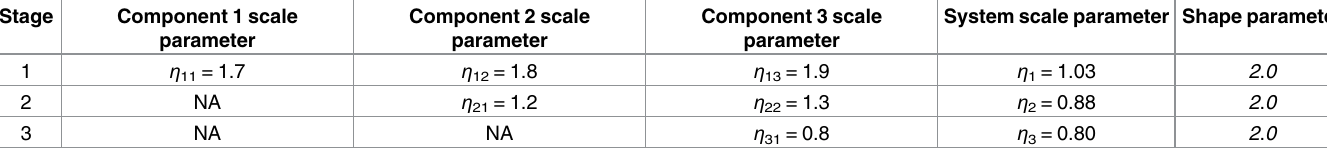
Table 3. Pre-specified parameters for Weibull numerical example.